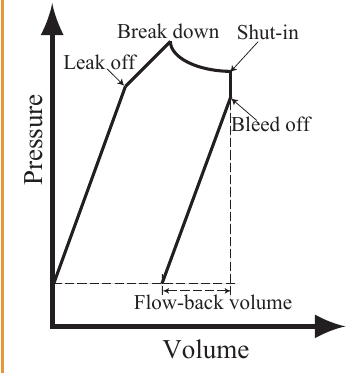
Figure 5. Relationship between pumping pressure and injected volume corresponding to the 2nd cycle in Fig.